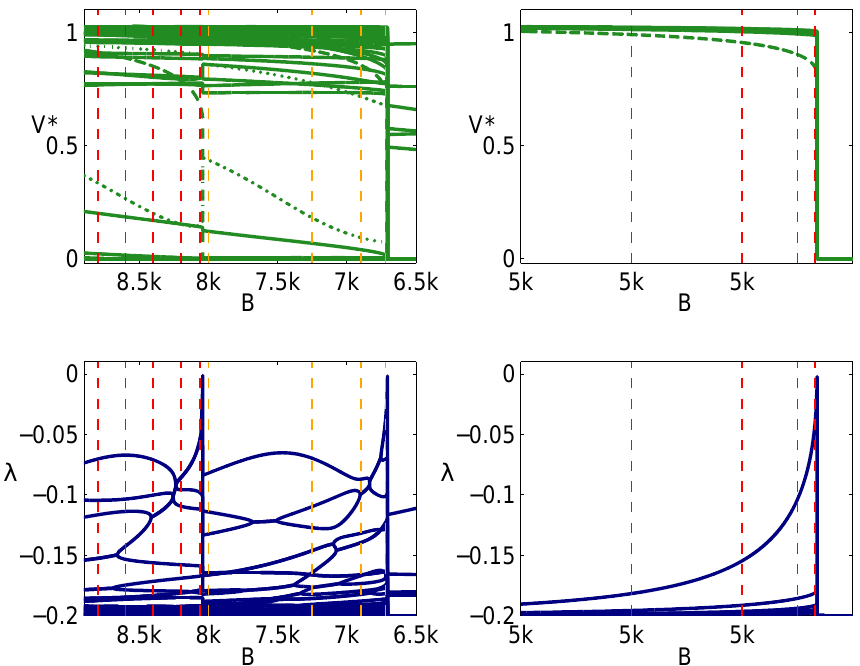
Fig. 5. Characteristics of RM1 (left) and RM2 (right), depending on parameter B . Top: Equilibrium vegetation cover at all elements (greenest solution). The elements identified as hotspots are dashed. Some elements are dotted only to be better distinguishable from others. Bottom: real part of eigenvalues characterising the linear stability of the corresponding solution of the time-continuous system. The vertical dashed lines indicate the B values of the stationary simulations used for the hotspot detection (red: bifurcation 1 in RM1 and RM2, orange: bifurcation 2 in